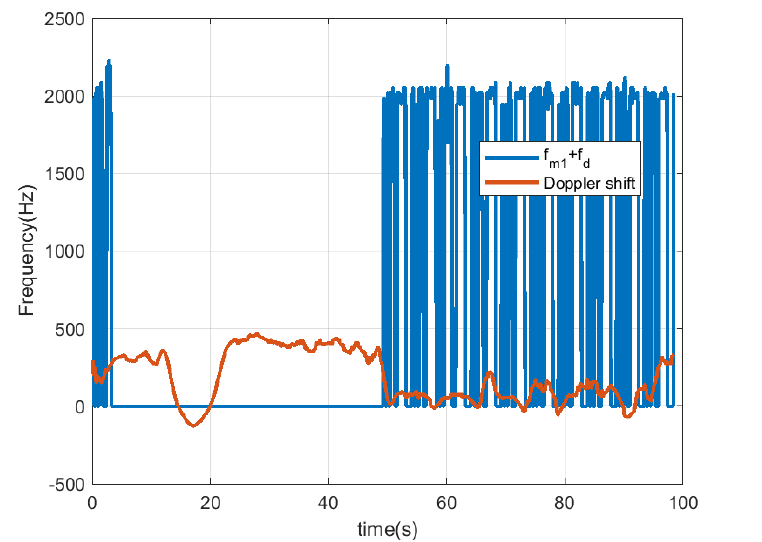
Figure 29. Data measurement using length 13 Barker codes when the scooter is in motion: scooter Doppler frequency estimate and detected frequency for bit 1. In this case, the tag is partially out of